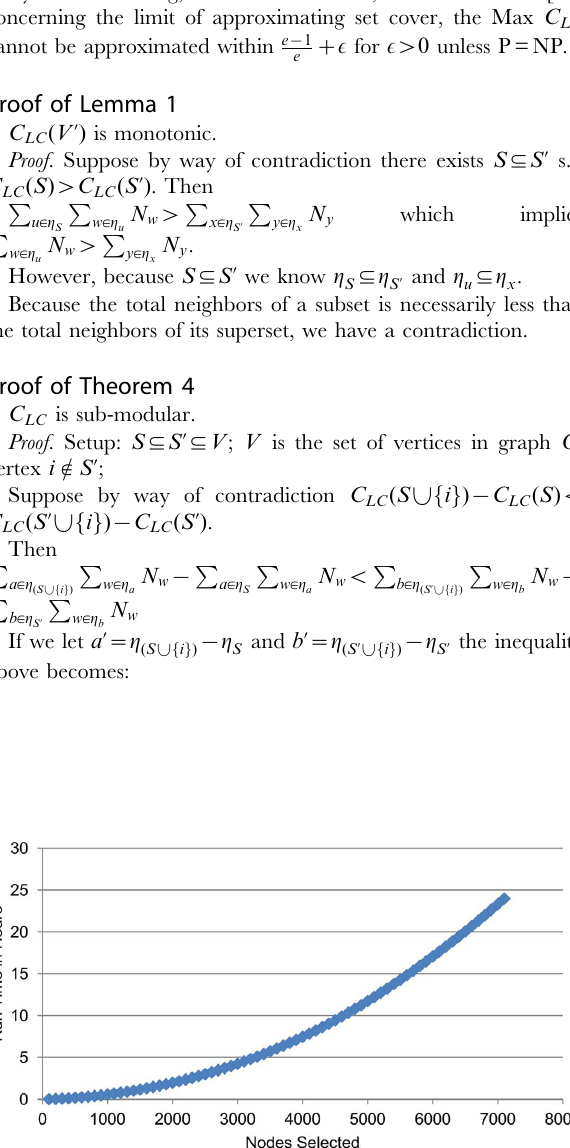
one next nearest neighbor e ib and no neighbors to that vertex, and